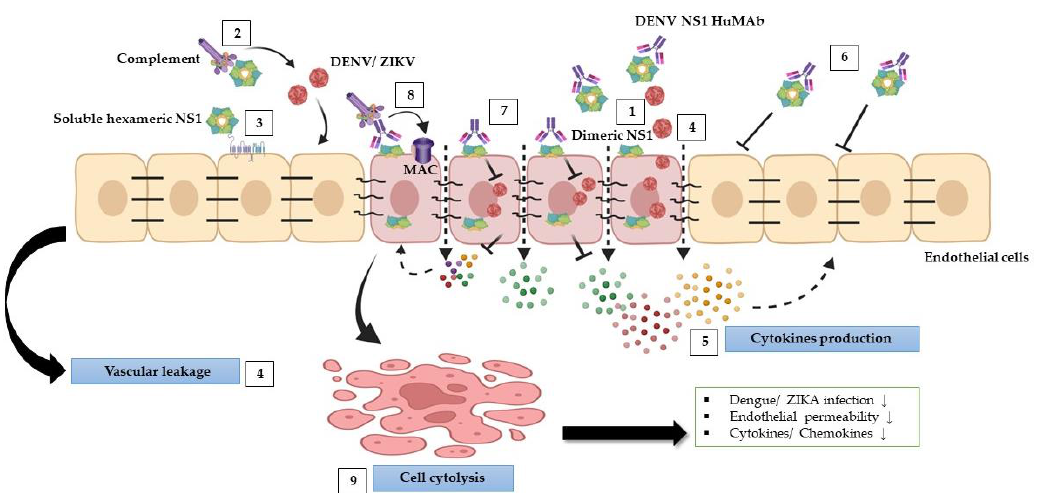
Figure 7. Schematic model of protective effects stimulated by DENV NS1 HuMAbs: during DENV and ZIKV infections, NS1 mediates multiple pathogenic pathways. (1) NS1 plays a role in DENV and ZIKV replication within cells. (2) NS1 disturbs complement proteins to bind to viruses leading viruses to escape from the complement attack. (3) Soluble NS1 interaction with endothelial cells leads to increased glycocalyx degradation. (4) Furthermore, NS1 modulates intercellular junction molecules, resulting in endothelial dysfunction and vascular leakage. (5) NS1 can activate inflam- mation by triggering several proinflammatory cytokines leading to cytokine storm, which may en- hance DENV and ZIKV infections and vascular leakage. (6) Anti-DENV NS1 HuMAb directly binds to soluble NS1 and supports viral neutralization. (7) The binding of DENV NS1 HuMAb to dimeric NS1 on the infected cell surface inhibits DENV and ZIKV replication. (8) NS1 and anti-DENV NS1 HuMAb interaction with the infected cells can stimulate complement membrane attack complex (MAC) formation and mediate cell cytolysis (9) that may attenuate DENV and ZIKV infections, en- dothelial permeability, and cytokines/chemokines secretion. Supplementary Materials: The following supporting information can be downloaded at: www.mdpi.com/xxx/s1, Figure S1: title; Table S1: title; Video S1: title. Author Contributions: R.S. and P.P. conceived the study, designed experiments, and analyzed the data. W.P. and S.K. participated in antibody production and purification. S.B. and S.K. participated in NS1 protein cloning and expression. K.B., S.A., S.C., A.Y. and P.R. helped in guiding the experi- mental design. R.S. wrote the manuscript. P.P. checked and revised the draft and final manuscript. Funding acquisition, P.P.; methodology, P.P.; supervision, P.P.; writing — review and editing, P.P. All authors have read and agreed to the published version of the manuscript.